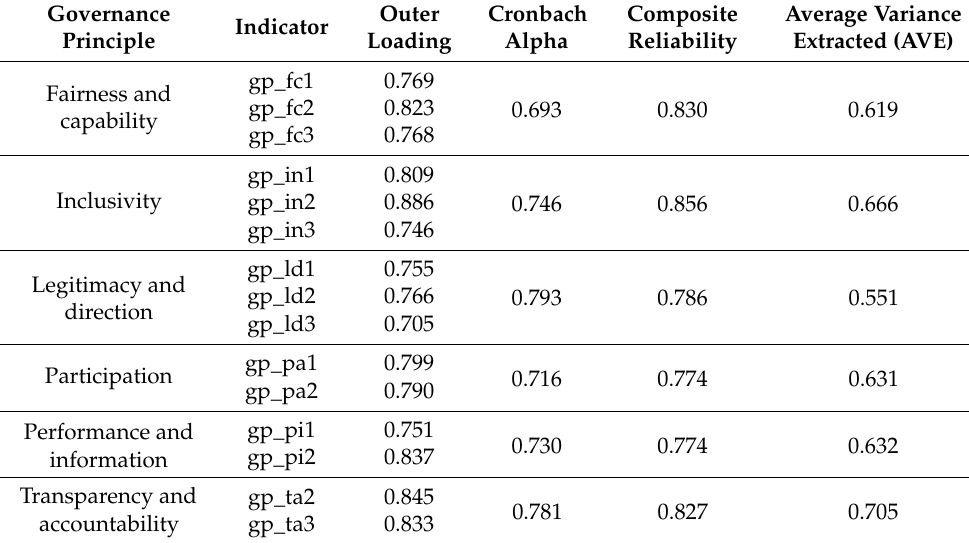
Table 7. Model validity: convergent validity.